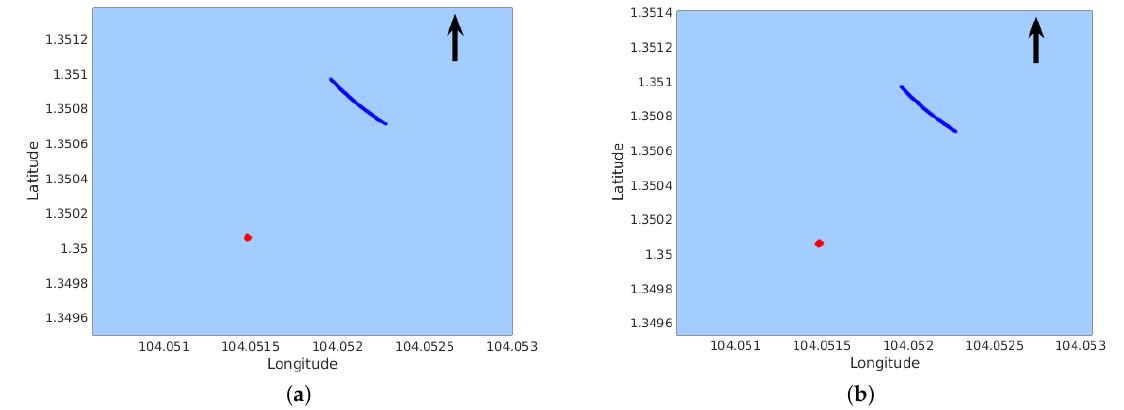
Figure 9. Obstacle mapping result of Seq-1. The red points are the reconstructed feature points from obstacles; The blue curve represents the trajectory of our USV; The arrow points to the direction of North. ( a ) Triangulation using one frame pair; ( b ) triangulation using ten frame pairs.